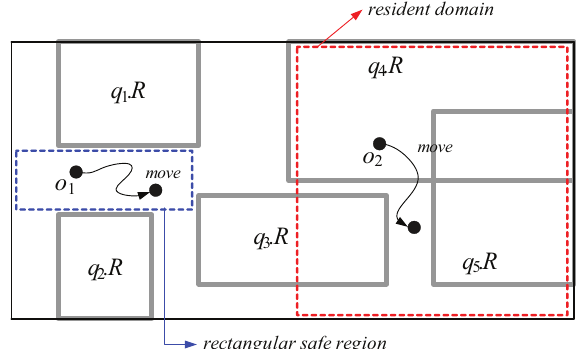
Figure 1. An example of the safe region and resident